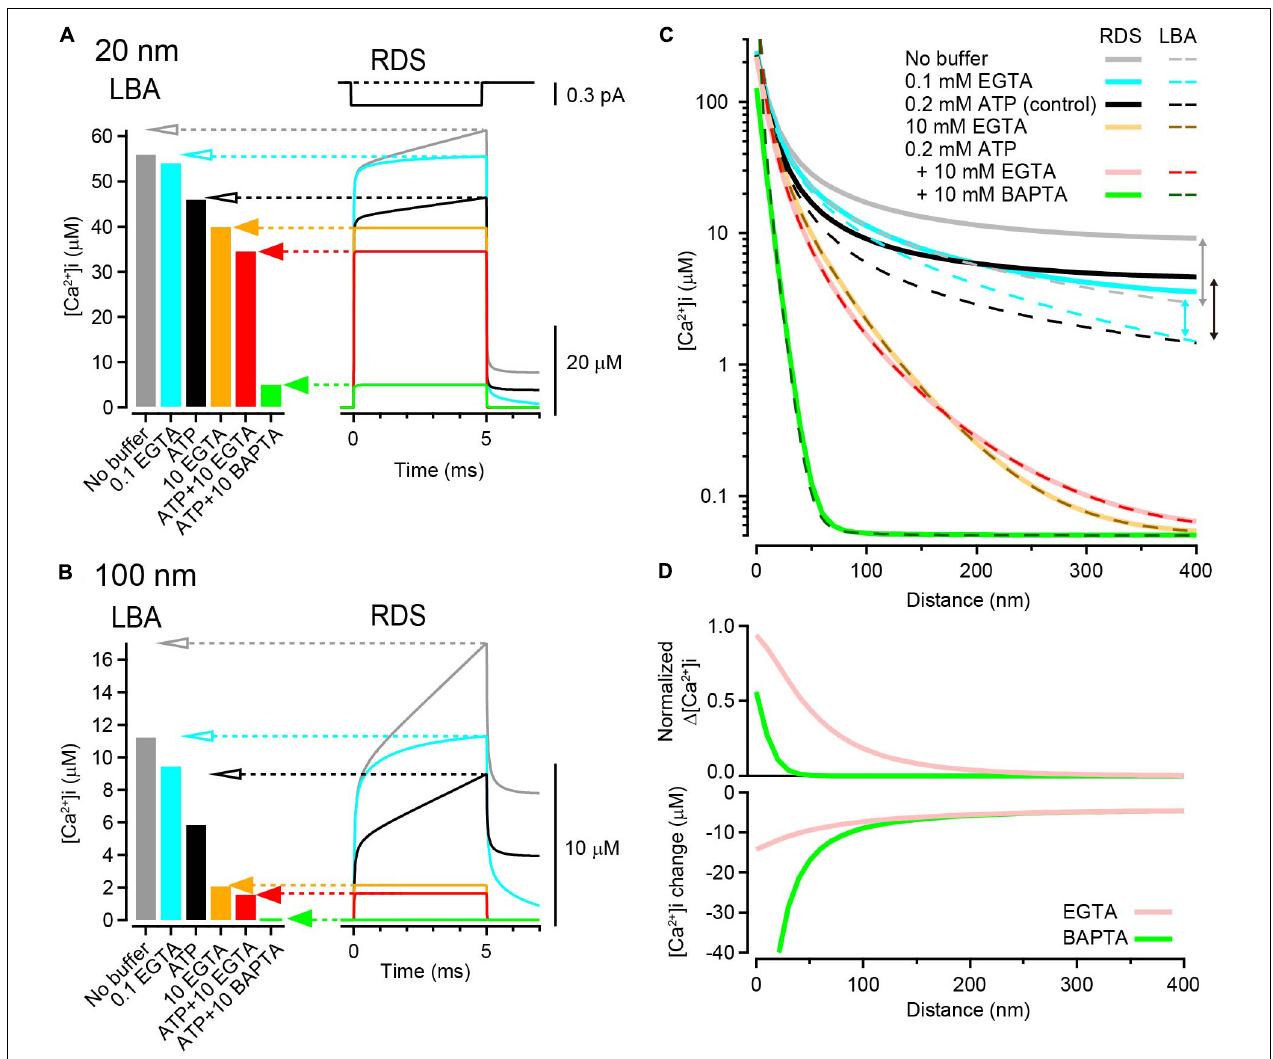
FIGURE 1 | Calculation of [Ca 2 + ] i gradients around an open VGCC. (A) left, [Ca 2 + ] i at 20 nm from the VGCC calculated using LBA under various buffer conditions. Single channel current amplitude was 0.3 pA. Right, Time dependent [Ca 2 + ] i changes calculated using RDS. Channel open duration was 5 ms (top). Under heavily buffered conditions, both estimates agreed (filled arrows), whereas under the weak or no-buffer conditions, LBA predicted lower [Ca 2 + ] i than the peak [Ca 2 + ] i of transients in RDS (open arrows). Resting [Ca 2 + ] i was 50 nM. (B) Same as (A) but at 100 nm from the VGCC. (C) Spatial gradients of [Ca 2 + ] i from LBA (dashed) and RDS (solid) in various buffer conditions. The vertical arrows indicate discrepancies between the two estimates. (D) Reduction of [Ca 2 + ] by 10 mM EGTA (pink) and BAPTA (green) against distance. Top, the reduction is represented as the ratio of the peak [Ca 2 + ] i in the presence of the chelator to that in the control (0.2 mM ATP). Bottom, the reduction is represented as the difference between the peak [Ca 2 + ] i in the presence of the chelator and that in the